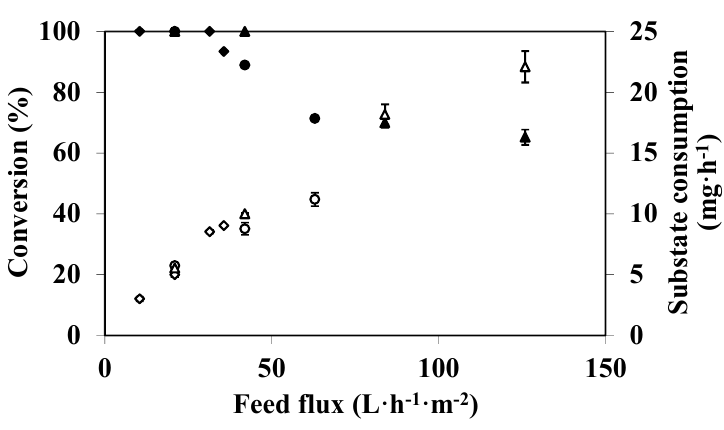
Figure 3. Feed flux effect on DMP conversion (closed symbols) and substrate consumption (open symbols) in an EMR used in a continuous dead-end filtration configuration (100 mg·L − 1 DMP in 50 mM citrate-phosphate buffer pH 4 with 0.1 mM CuSO 4 , T = 40 °C, membrane pore diameter: 0.2 µm (( ◊ , ♦ ), 0.8 µm ( ○ , ● ), and 1.4 µm ( ∆ , ▲